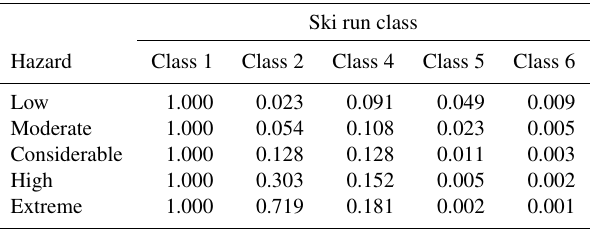
Table 5. Odds ratios of each ski run class being open with increas- ing avalanche hazard relative to ski run class